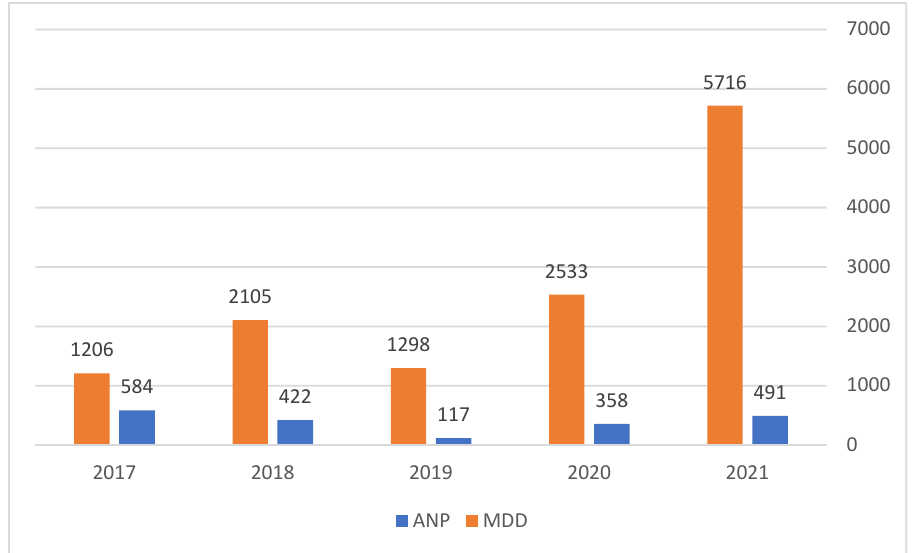
Figure 3. Bitcoin average NP and MDD per trade for 2017–2021. Note: ANP = average trade net profit, MDD = maximum loss per trade. The data for 2021 is until the end of September 2021.